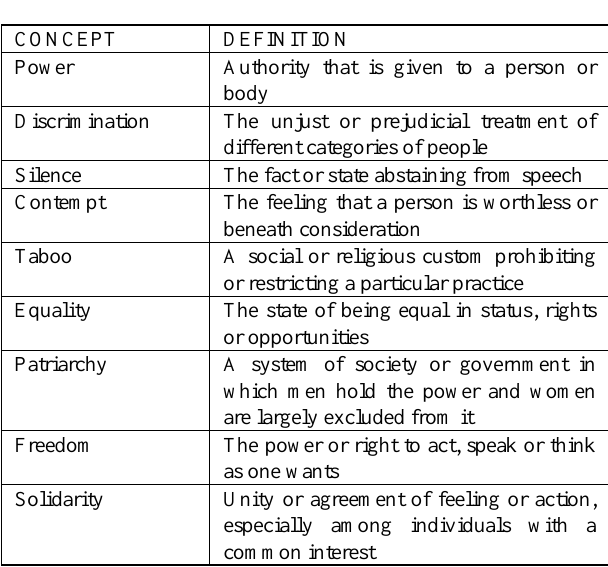
Table 1: Examples of concepts described and their definition ( Source of the definitions: OxfordLanguages